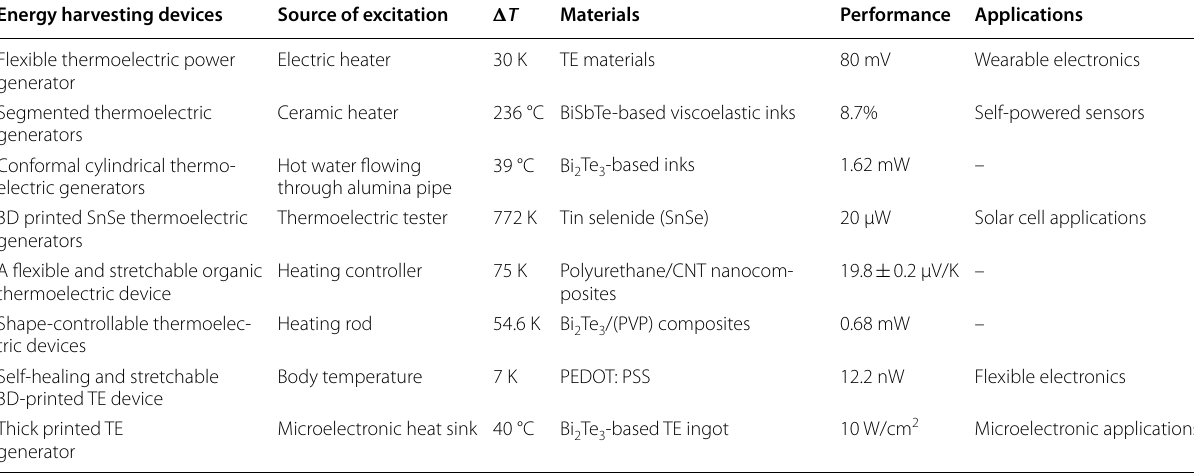
The references of the research papers cited in this table are provided in the Additional file